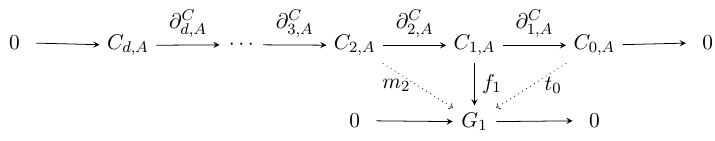
Figure 6 . Chain complexes that de(cid:12)ne Abelian 1-gauge theories in d dimensions for a subregion A , as explained in 4. The maps are the ones explained in 5 restricted to the subcomplex K A . is a subcomplex of K . Therefore, following the general procedure shown in section 4.1, we can construct for region A the chain complexes shown in (cid:12)gure